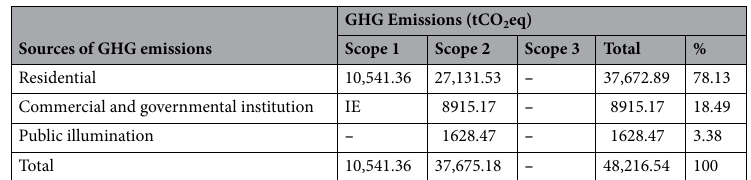
Table 2. GHG emissions from the energy sector, by scope and source of